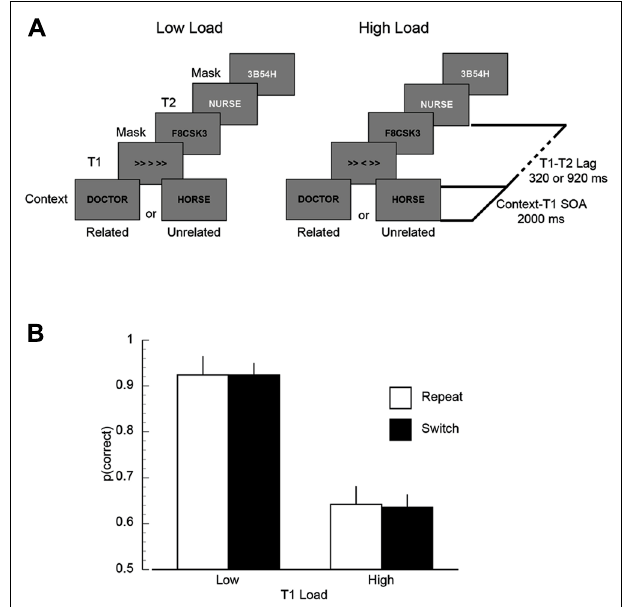
FIGURE 1 | (A) A schematic illustration of the trial sequence in Experi- ment 1. (B) Mean proportion of correct responses on the first target (T1) task, plotted as a function ofT1 load (high/low) and inter-trialT1-load dependency (repeat/switch). In this and subsequent figures, error bars represent the standard error of the mean calculated in a manner appropriate for within subjects experimental designs (Loftus and Masson, 1994).